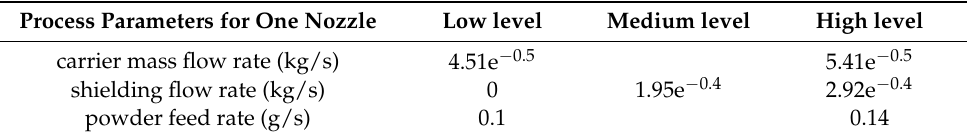
Table 1. Evaluated experimental factors.